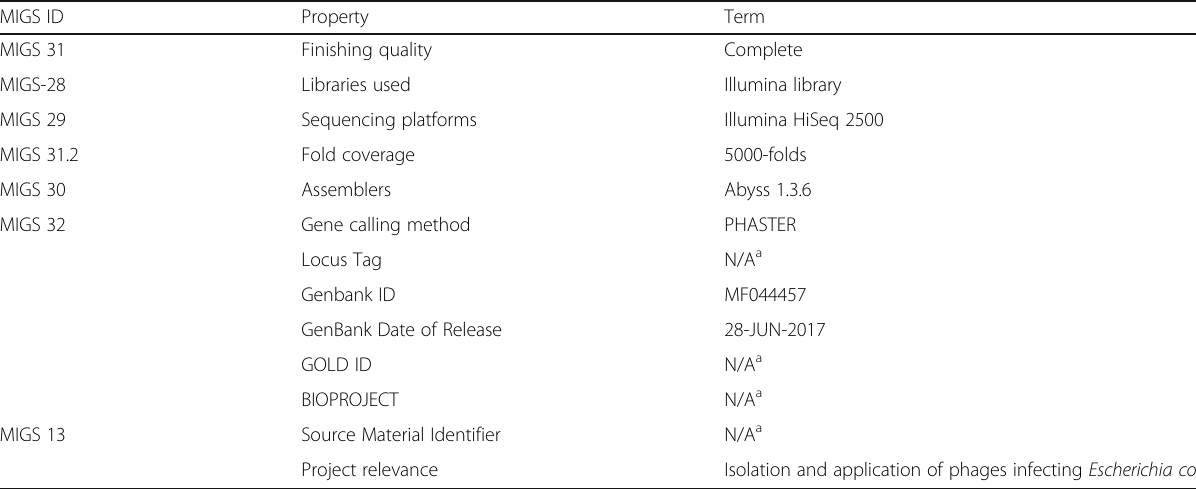
Table 2 Project